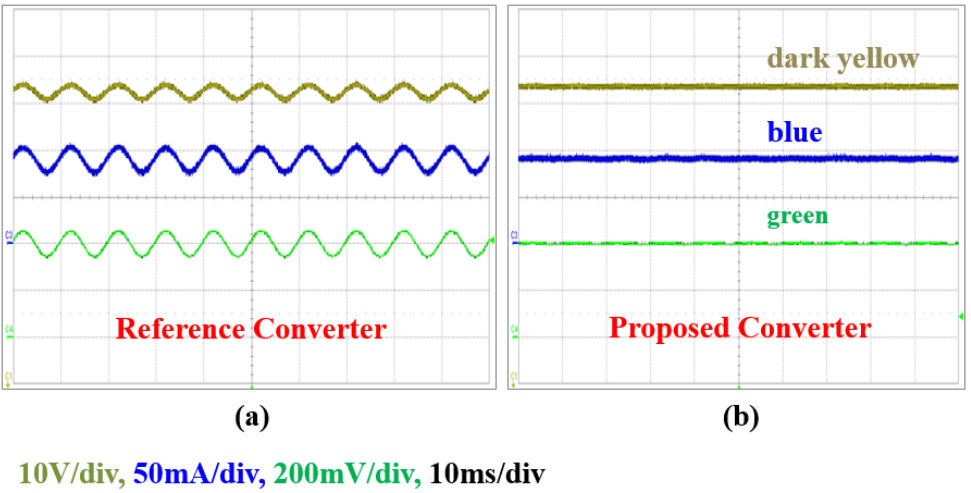
Figure 7. Waveform of the output voltage (dark yellow), output current (blue) and light output (green) of the ( a ) reference converter, ( b ) proposed converter.